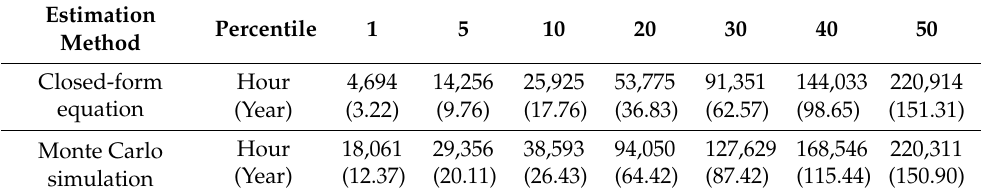
Table 3. Percentile estimation of the return-spring at normal use